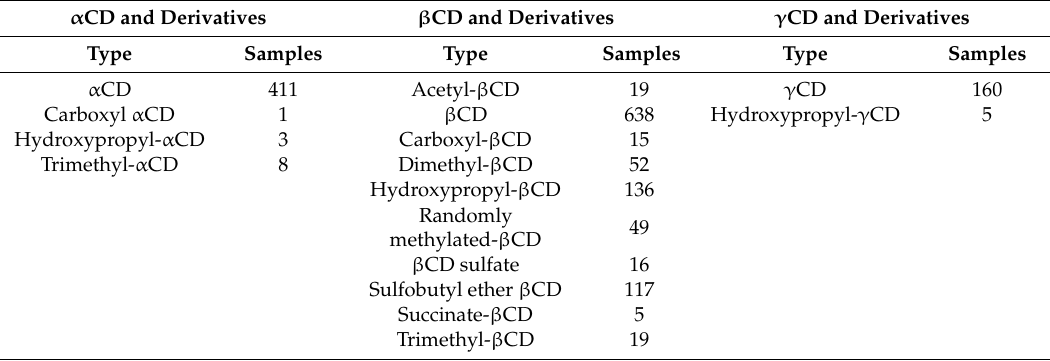
Table 1. Distribution of cyclodextrin (CD) derivatives in the final